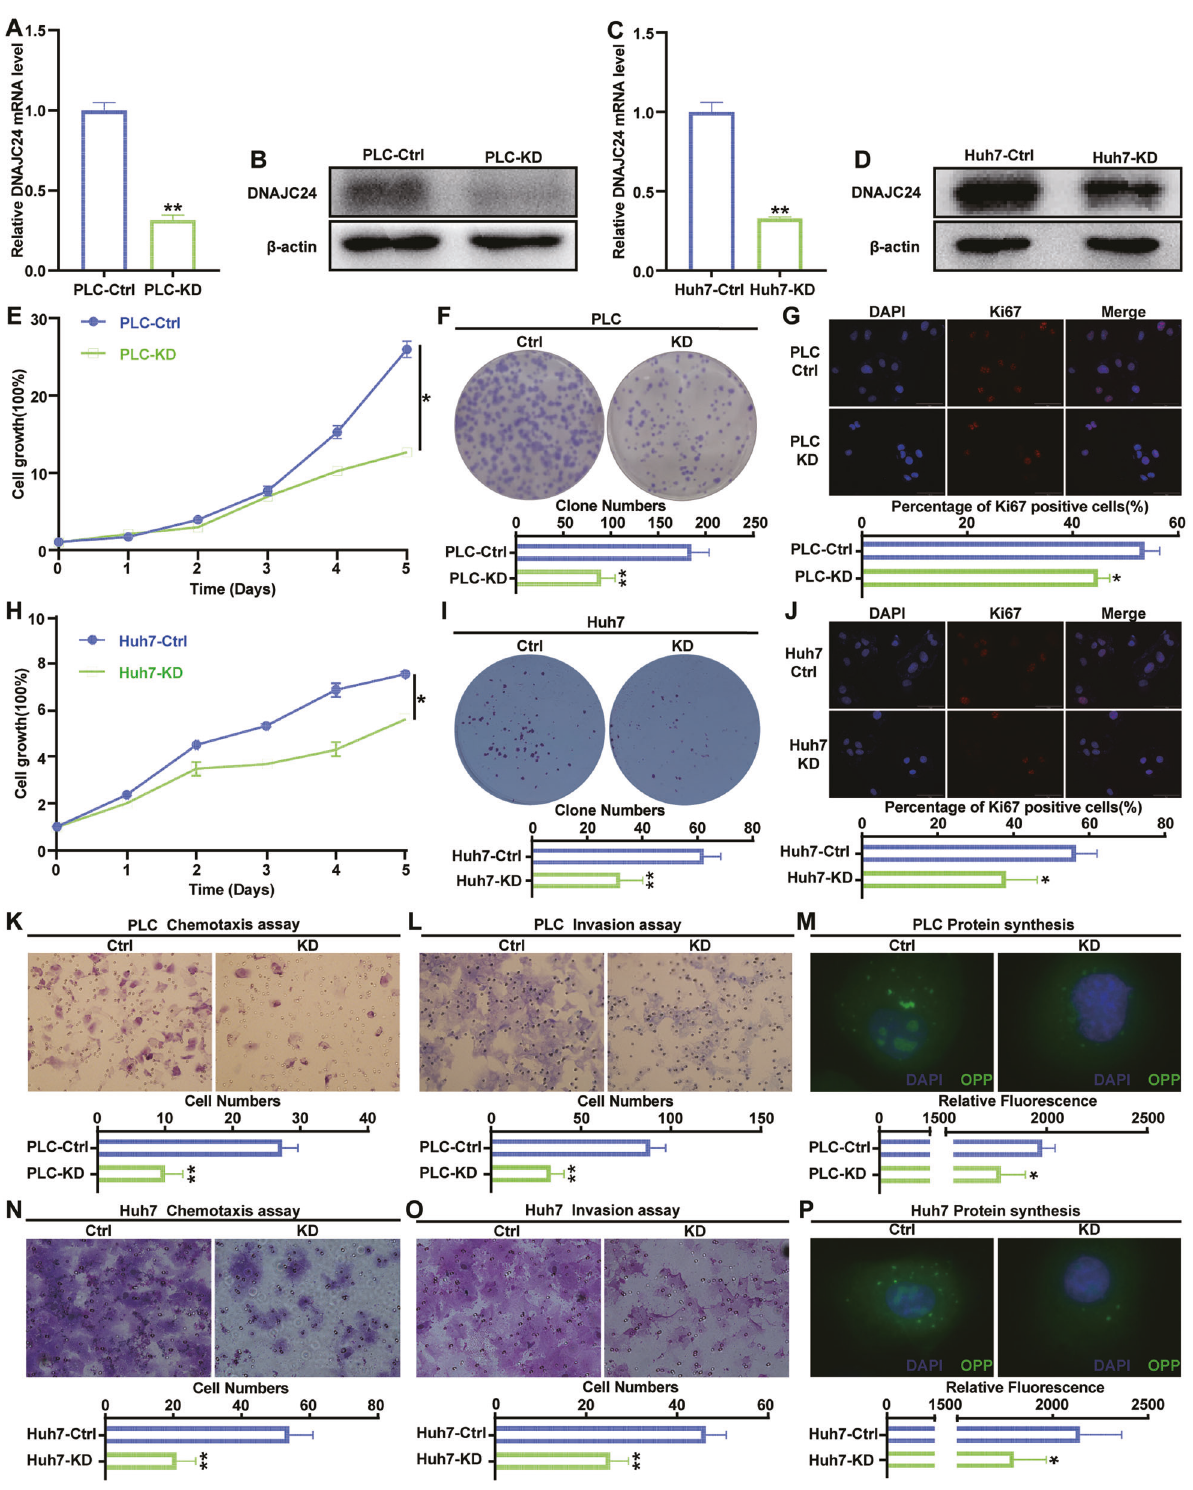
Fig. 4 Knockdown of DNAJC24 inhibits proliferation, motility, and protein synthesis in HCC cells in vitro. A , C PLC and Huh7 cells were infected with a lentivirus to produce stable DNAJC24 knockdown (KD) cells. qRT-PCR was performed to determine levels of DNAJC24 mRNA. β -actin was used as an internal control. B , D Western blotting was performed to determine levels of DNAJC24 protein. E , H CCK-8 cell viability assay analysis of the impact of DNAJC24 knockdown on PLC ( E ) and Huh7 ( H ) cell growth. Results were normalized to viability at day 0 and represented as fold change. F , I Colony formation assay showing the effects of DNAJC24 knockdown on PLC ( F ) and Huh7 ( I ) cell growth. G , J Immuno fl uorescence staining detected Ki67 expression in DNAJC24-KD cells and control cells. Representative images and Ki67 positive cell rates are as shown. K , L , N , O Chemotaxis ( K , N ) and Matrigel invasion ( L , O ) assays were used to detect the effect of DNAJC24 knockdown on PLC ( K , L ) and Huh7 ( N , O ) motility. M , P Newly synthesized protein was detected in PLC ( M ) and Huh7 ( P ) cells after DNAJC24 knockdown using a protein synthesis assay kit. Data were presented as mean ± SEM. n = 2 – 3. * P < 0.05, ** P < 0.01. Cell Death and Disease (2022)